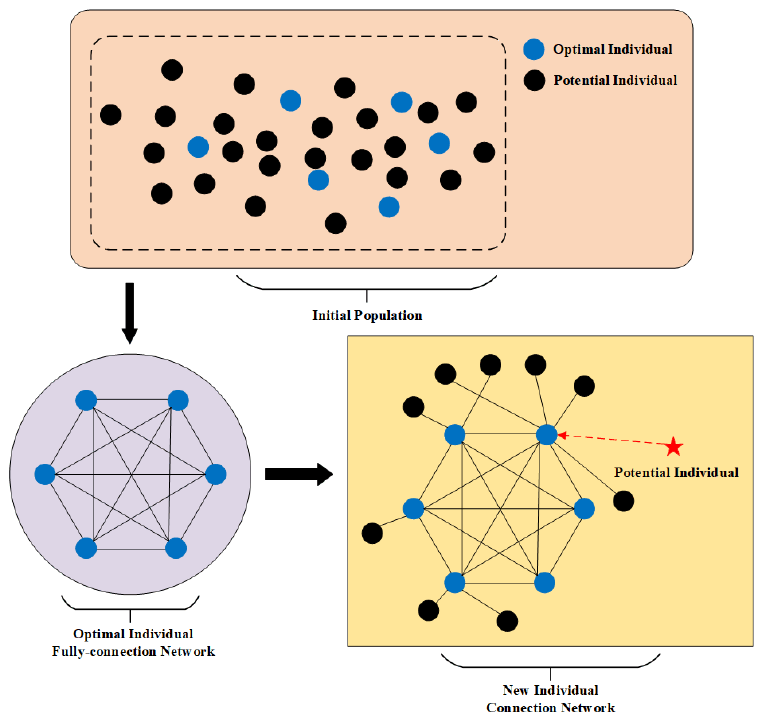
Figure 4. The SN topology population construction